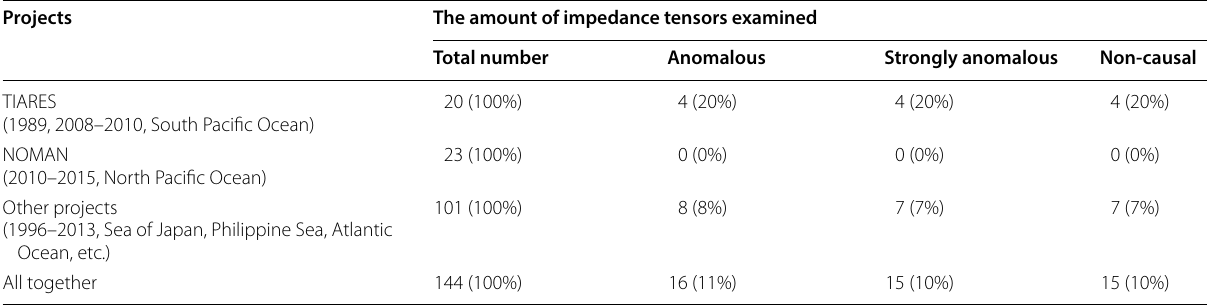
Table 3 The DR violation statistics for the impedance tensors from the integrated offshore MT database of ERI and JAMSTEC Projects The amount of impedance tensors examined